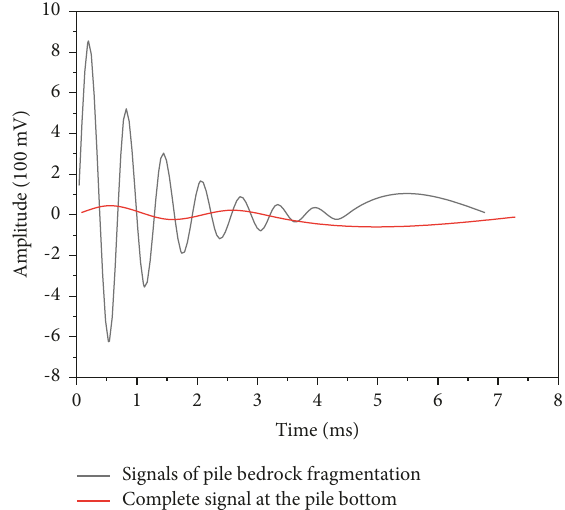
Figure 4: The ideal reflection signal when the foundation rock at the bottom of the pile is extremely